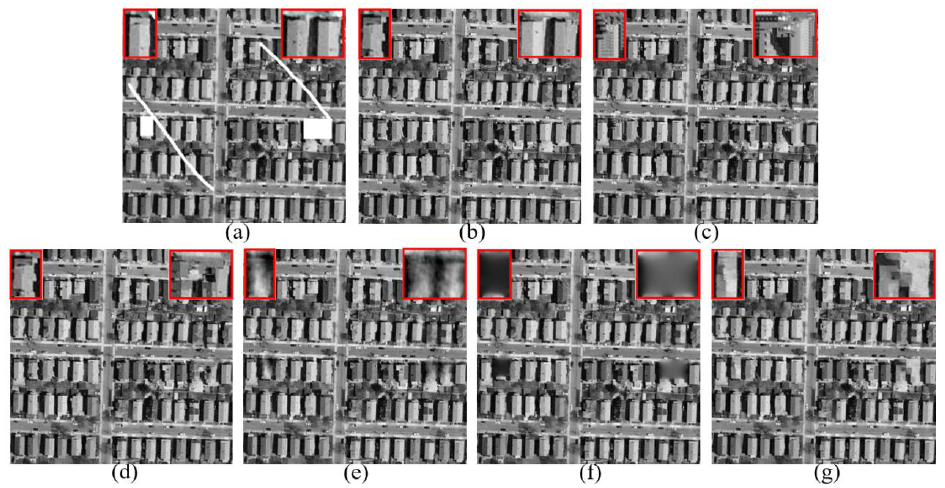
Figure 5. Comparison of Visual Effects on Aerial Image. ( a ) Corrupted Buildings Image; ( b ) Our Result Using 16 × 16 Patch; ( c ) Our Result Using 8 × 8 Patch; ( d ) Result of [26] Using 16 × 16 pixels Patch; ( e ) Result of MCA; ( f ) Result of MRF; ( g ) Result of Texture Synthesis.